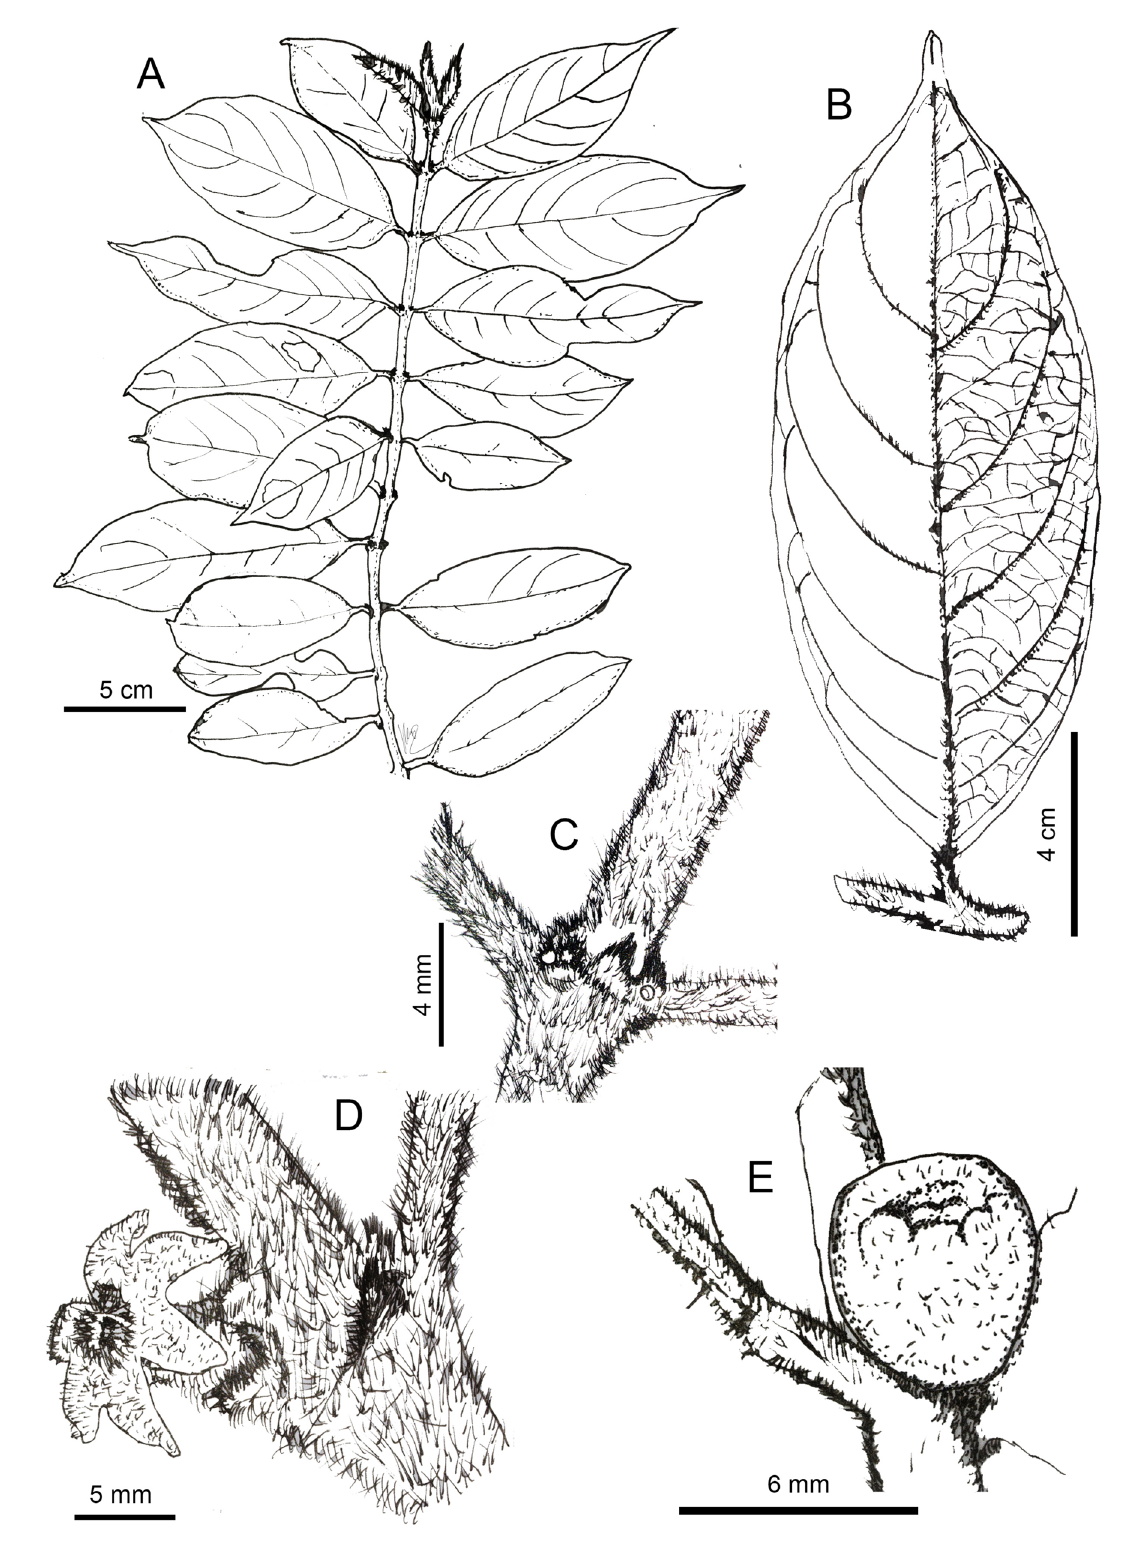
Fig. 2. Lasianthus naikii V.S.Dang & Vuong sp. nov. A . Branch. B . Abaxial leaf surfaces. C . Stipule. D . Close-up of flower. E . Fruit. Line drawings from the holotype ( Dang 453 ) by Ba-Vuong